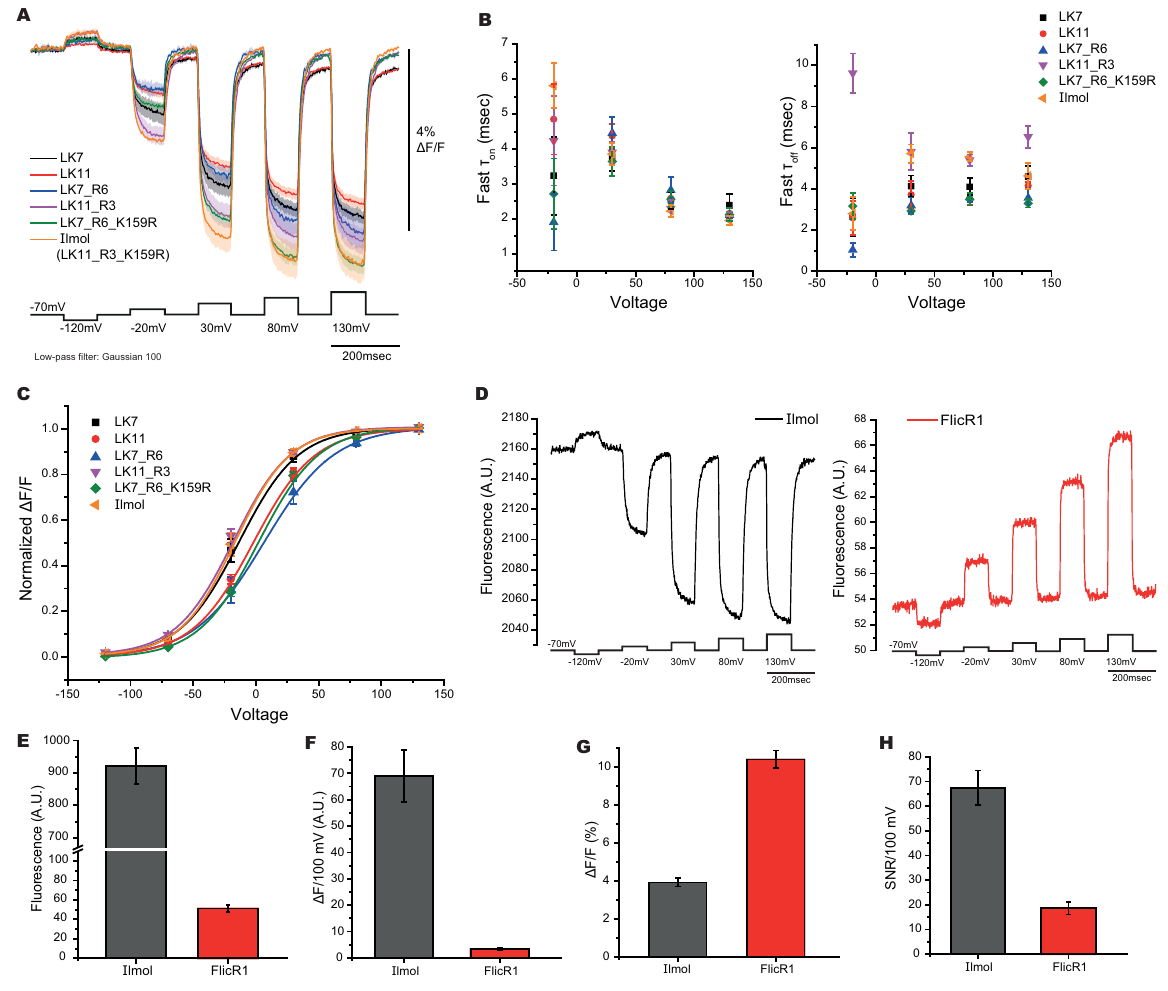
Figure 4. Optical properties of Ilmol. ( A ) Optimizing multiple parameters slightly improves signal size. Traces from two linker lengths, LK7 and LK11, were compared to the optimized linker charge composition, LK7_R6 and LK11_R3, and FP mutations, LK7_R6_K159R and LK11_R3_K159R (Ilmol). ( B ) Time constants of constructs in A. ( C ) Voltage range of constructs in A. ( D ) Comparison of Ilmol to FlicR1. Representative traces of Ilmol (left) or FlicR1 (right) in response to voltage when expressed in HEK 293 cells. The voltage protocol was the same for both constructs (average of 16 trials). ( E ) Average brightness for Ilmol and FlicR1 (n > 60 for both constructs in HEK 293 cells). ( F ) Average change in fluorescence for Ilmol and FlicR1 per 100 mV depolarization of the plasma membrane when expressed in HEK 293 cells. ( G ) Average fractional fluorescence change per 100 mV. ( H ) SNR for 100 mV depolarization of the plasma membrane (n ≥ 4 for all